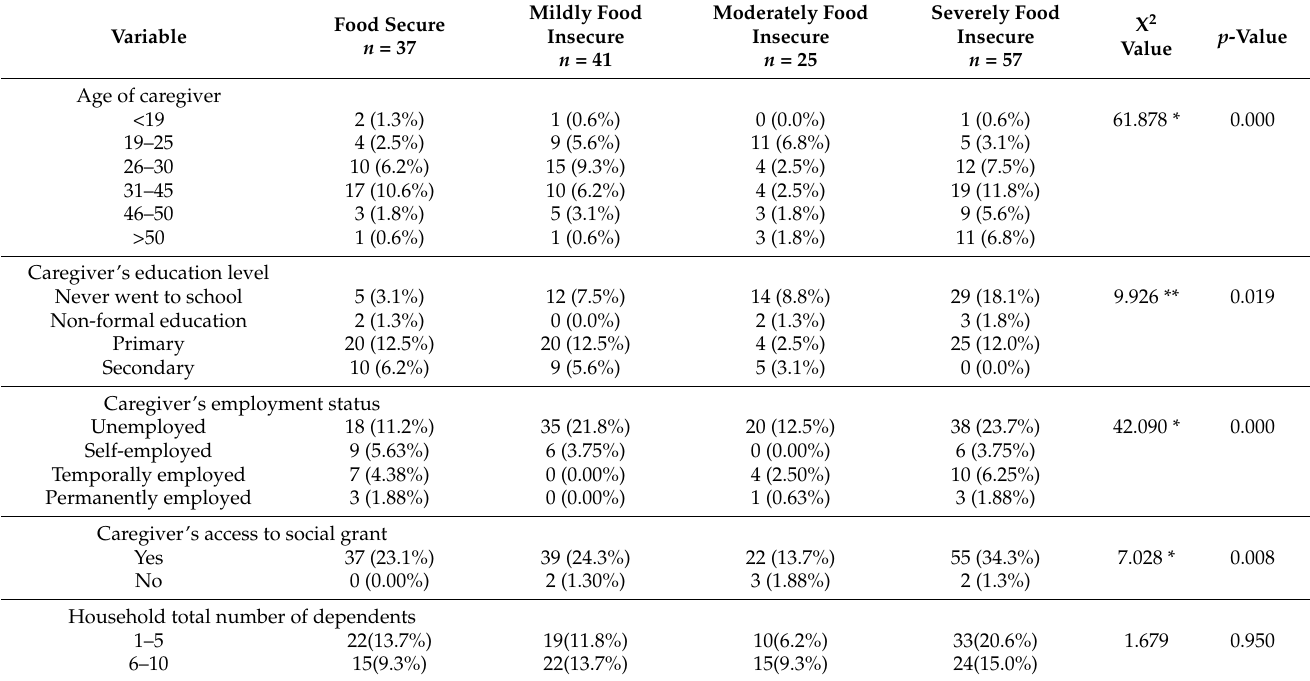
Table 5. Chi-square test and Pearson correlation between household food security status (HFIAS) and selected explanatory